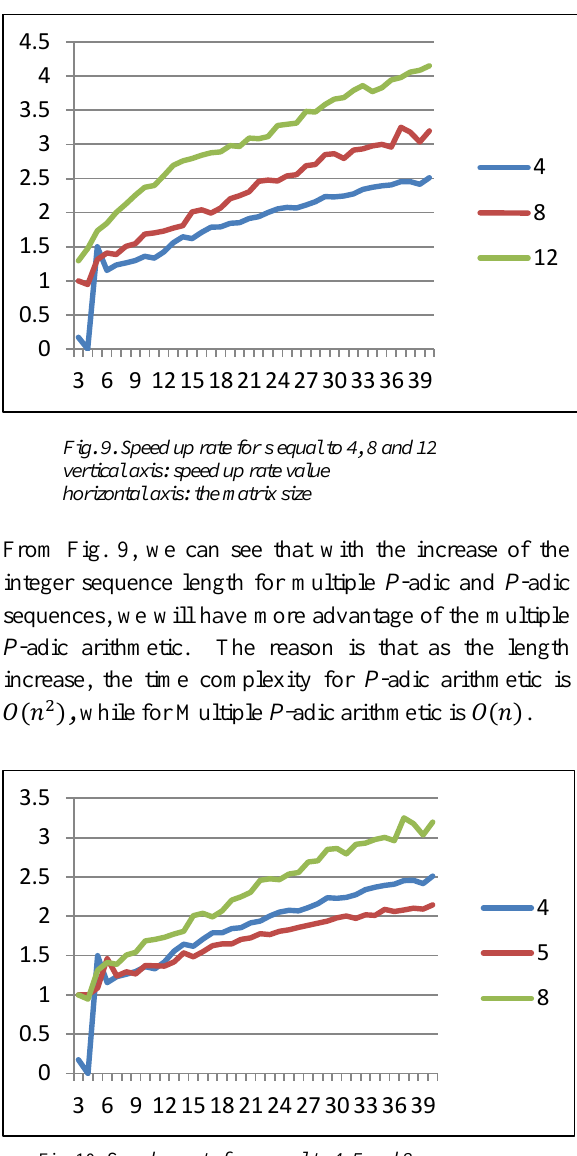
Fig. 10. Speed up rate for s equal to 4, 5 and 8 vertical axis: speed up rate value horizontal axis: the matrix size